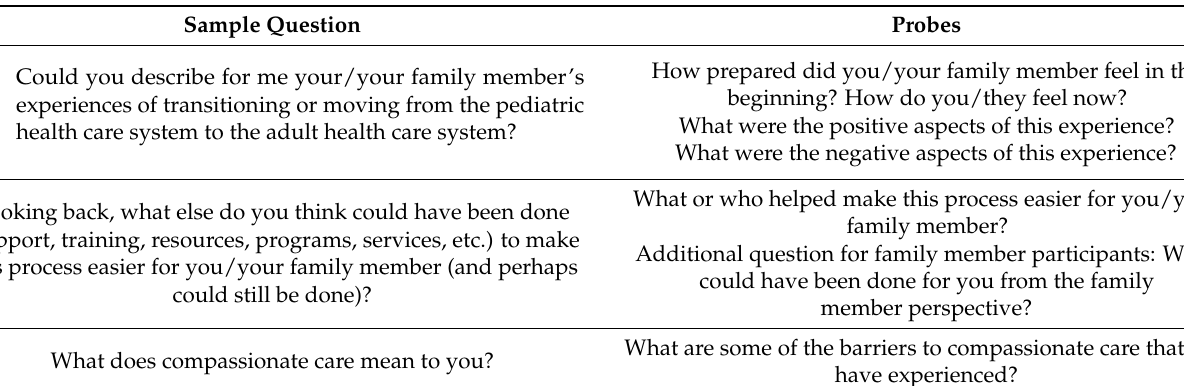
Table 1. Sample Interview